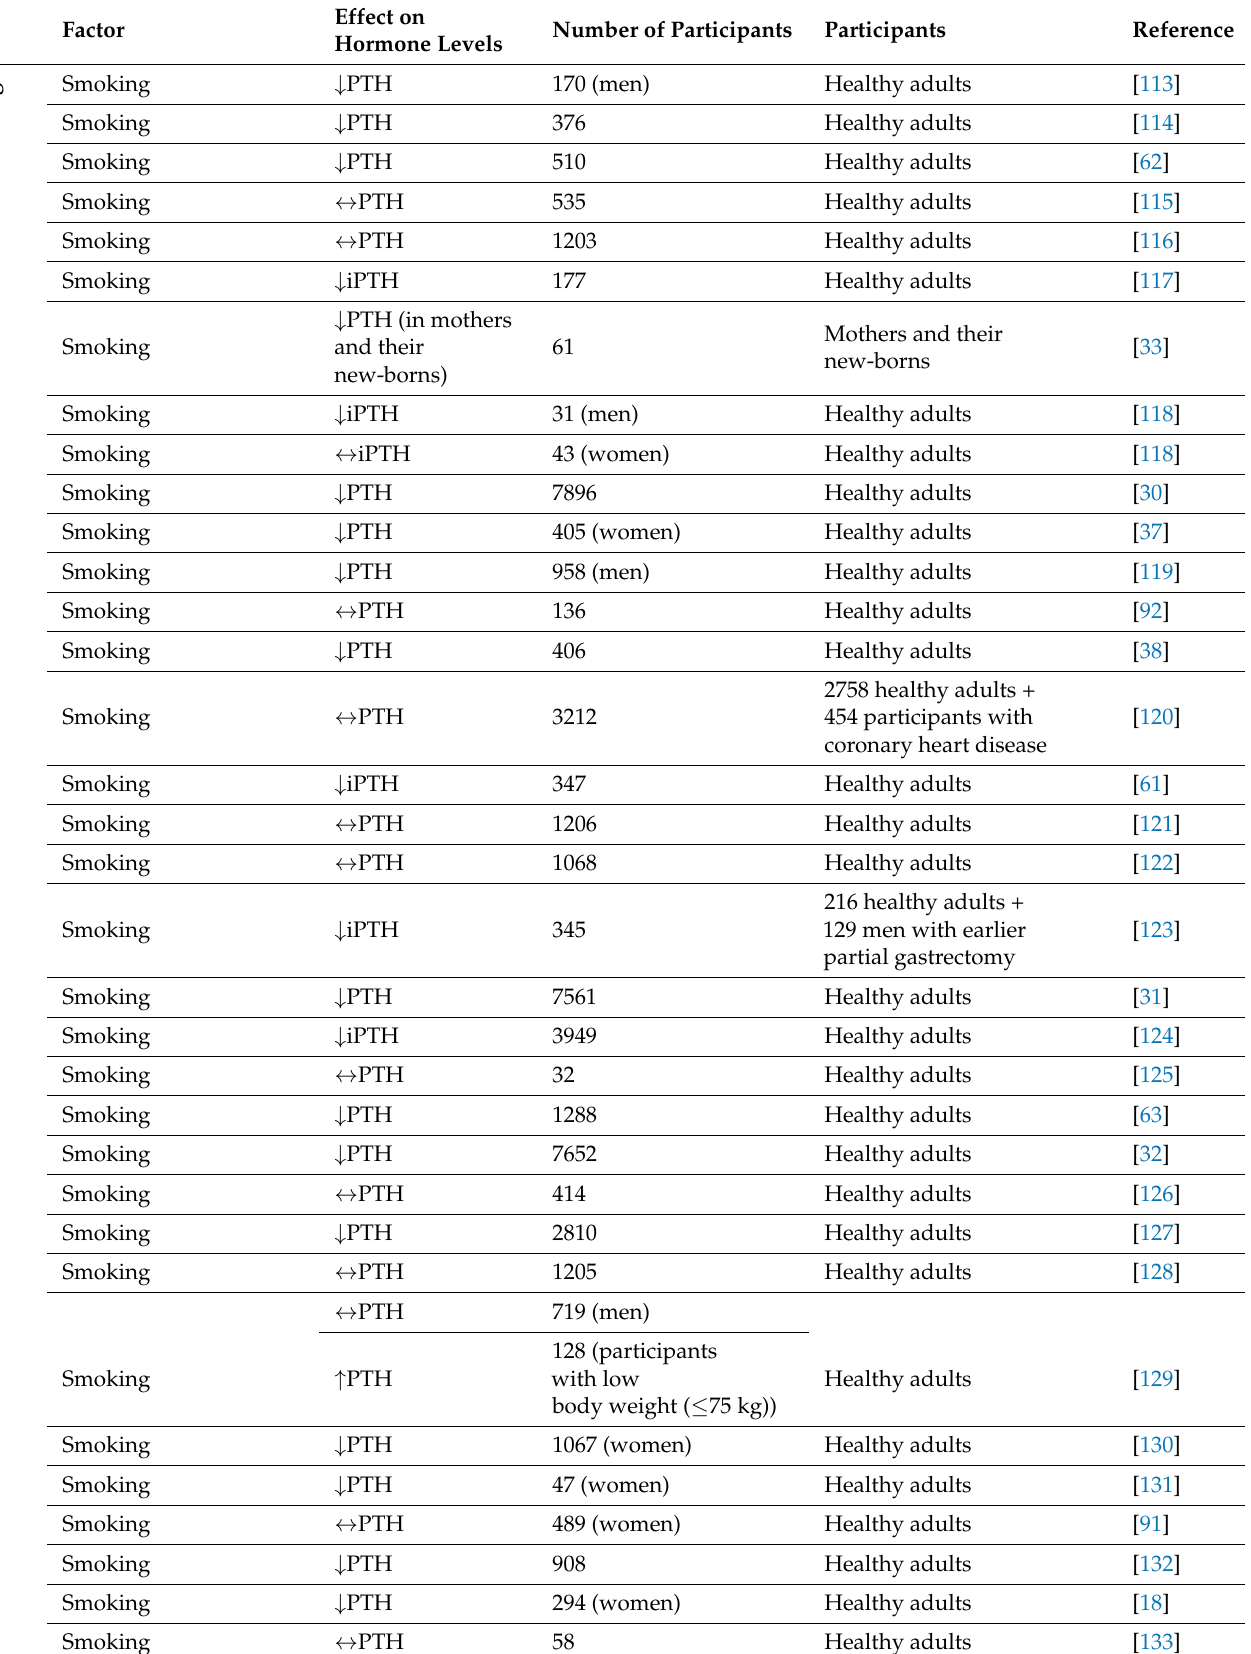
Table 1. Lifestyle factors that affect PTH levels in